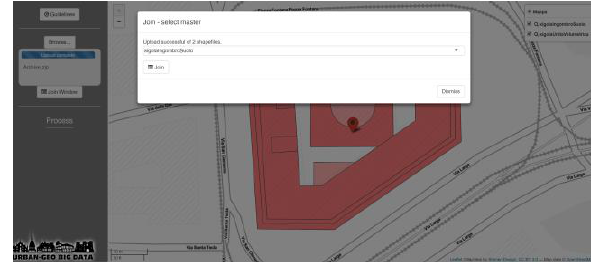
Figure 6. ZCityGML front-end after initial upload of a simple building